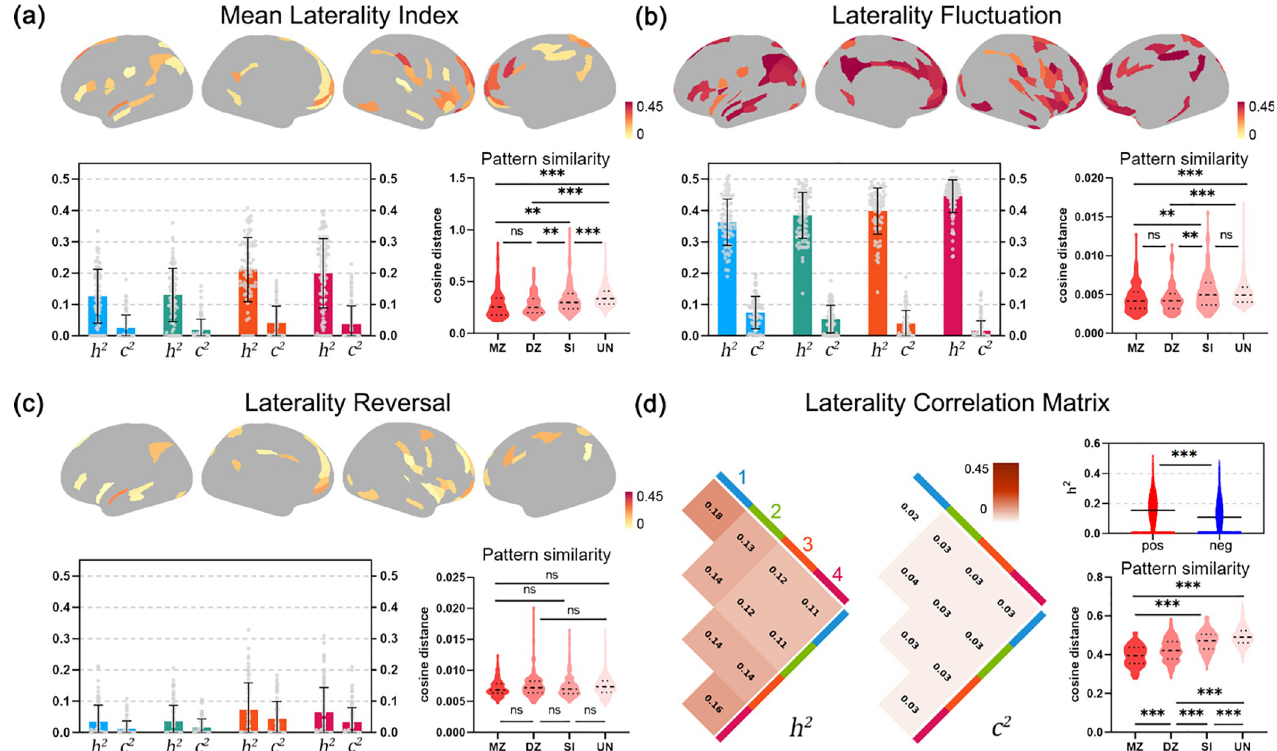
Fig 7. Heritability of dynamic laterality. (a-c) Heritability analysis of MLI, LF, and LR. Upper: Heritability ( h 2 ) of each brain region. Only the regions with h 2 of p < 0.05 are retained. Lower left: The h 2 and common environmental factors ( c 2 ) for each cluster, and each data point represents a brain region. Lower right: The cosine distance between whole brain map for each pair of MZ twins, DZ twins, SI, and UN. Asterisk indicates the significant difference between the groups (one-way ANOVA). (d) Heritability of lateralization correlation matrix. Left: Average h 2 and c 2 in 4 clusters. Upper right: Differences in heritability between the positive and the negative links, i.e., links with positive or negative correlation in laterality. Lower right: The cosine distance of laterality correlation matrix of each pair of MZ, DZ, SI, and UN. The error bar represents the mean value ± 1 SD. One asterisk ( � ), p < 0.05; 2 asterisks ( �� ), p < 0.01; 3 asterisks ( ��� ), p < 0.001; ns, nonsignificant. Pos, positive correlation; neg, negative correlation. The underlying data for this figure can be found in S4 Data. DZ, dizygotic; LF, laterality fluctuations; LR, laterality reversal; MLI, mean laterality index; MZ, monozygotic; SI, sibling; UN, unrelated